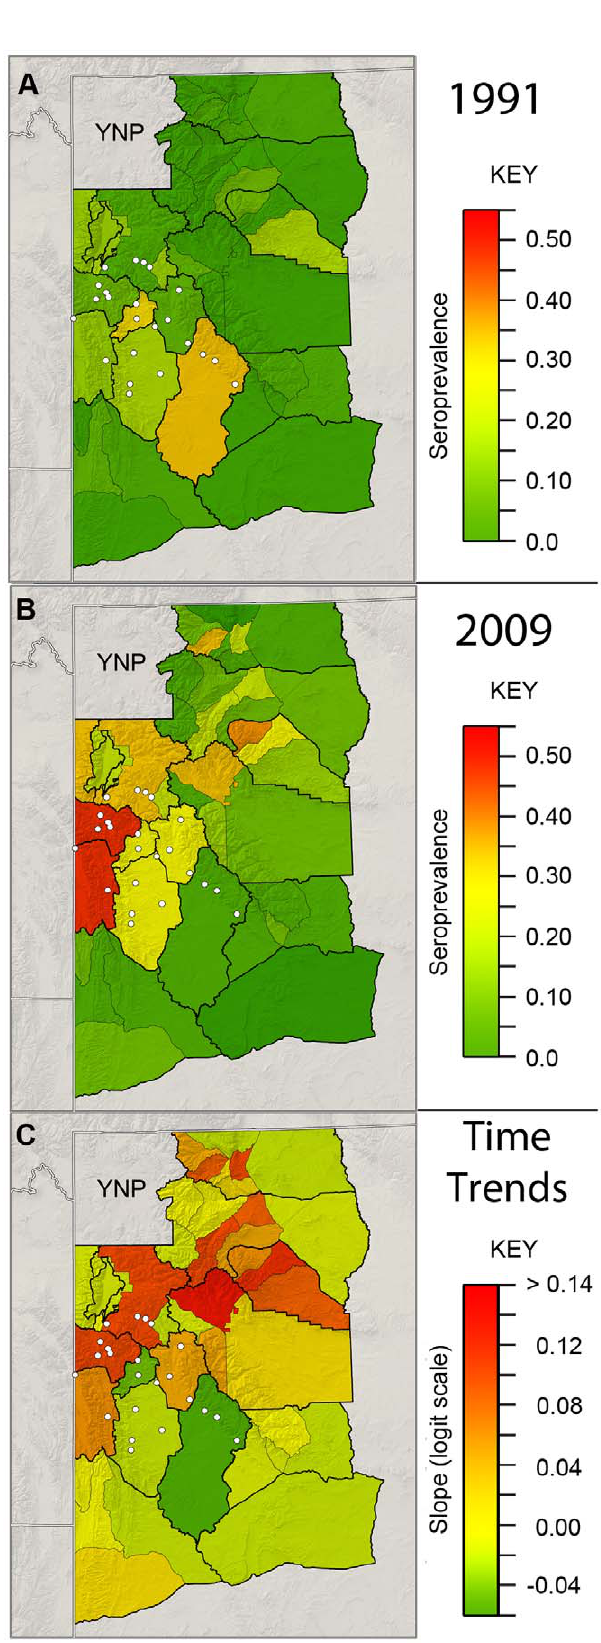
Figure 5. Maps of the brucellosis seroprevalence estimates for adult female elk and the annual trends. The estimates for 1991 (A),